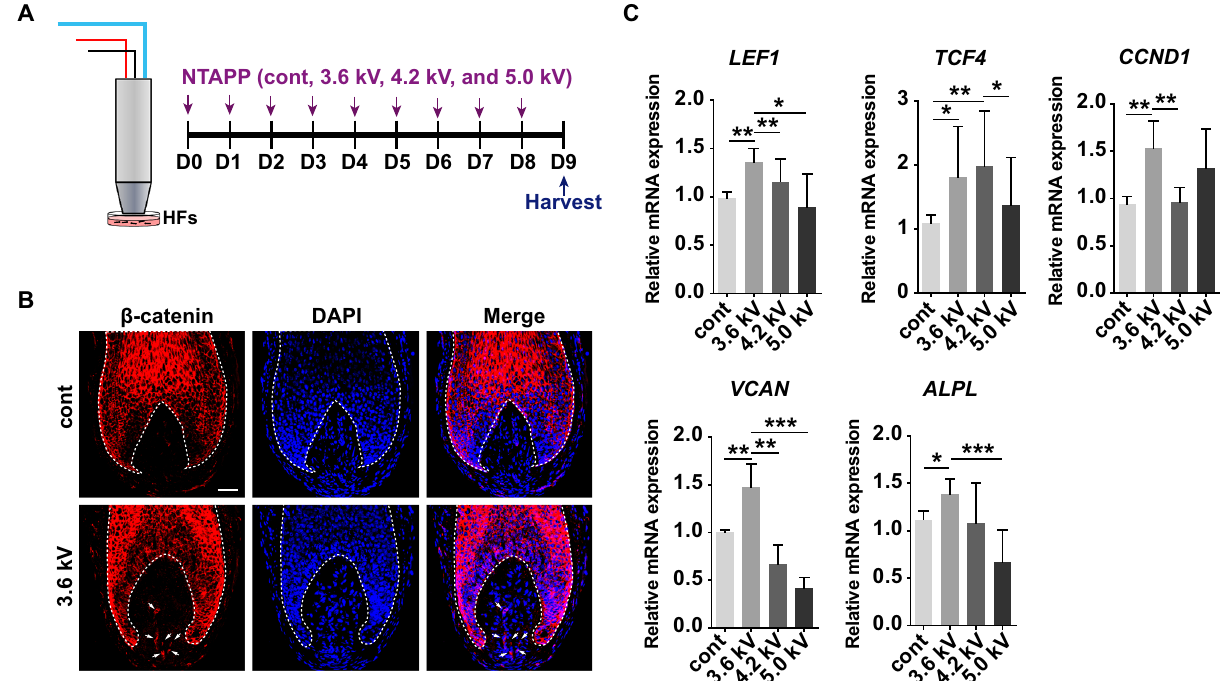
Figure 3. NTAPP activates the Wnt/β-catenin pathway in dermal papilla during hair organ culture. ( A ) Scheme of NTAPP treatment of hair follicles. Isolated human hair follicles (hHFs) were treated with NTAPP (3.6, 4.2, and 5.0 kV) for 1 min on 8 consecutive days. ( B ) Immunofluorescent staining of β-catenin in hHFs. White arrows mark β-catenin staining in dermal papilla (DP). Dotted lines highlight the border between hair keratinocytes and DP cells. Scale bar = 50 μm. ( C ) Quantitative RT-PCR analysis of the selected genes. Results are expressed as mean ± S.D. from five independent experiments (at least 60 follicles in each experiment). p values were determined by one-way ANOVA. * p < 0.05, ** p < 0.01, *** p < 0.001 (vs.